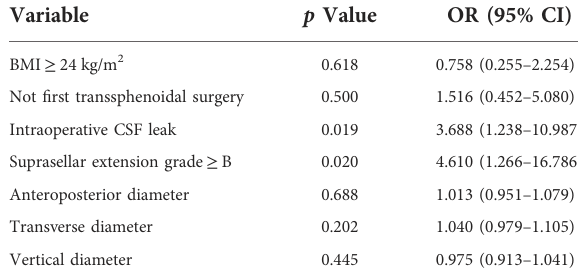
TABLE 3 Univariate analysis for predictors of postoperative CSF leak.